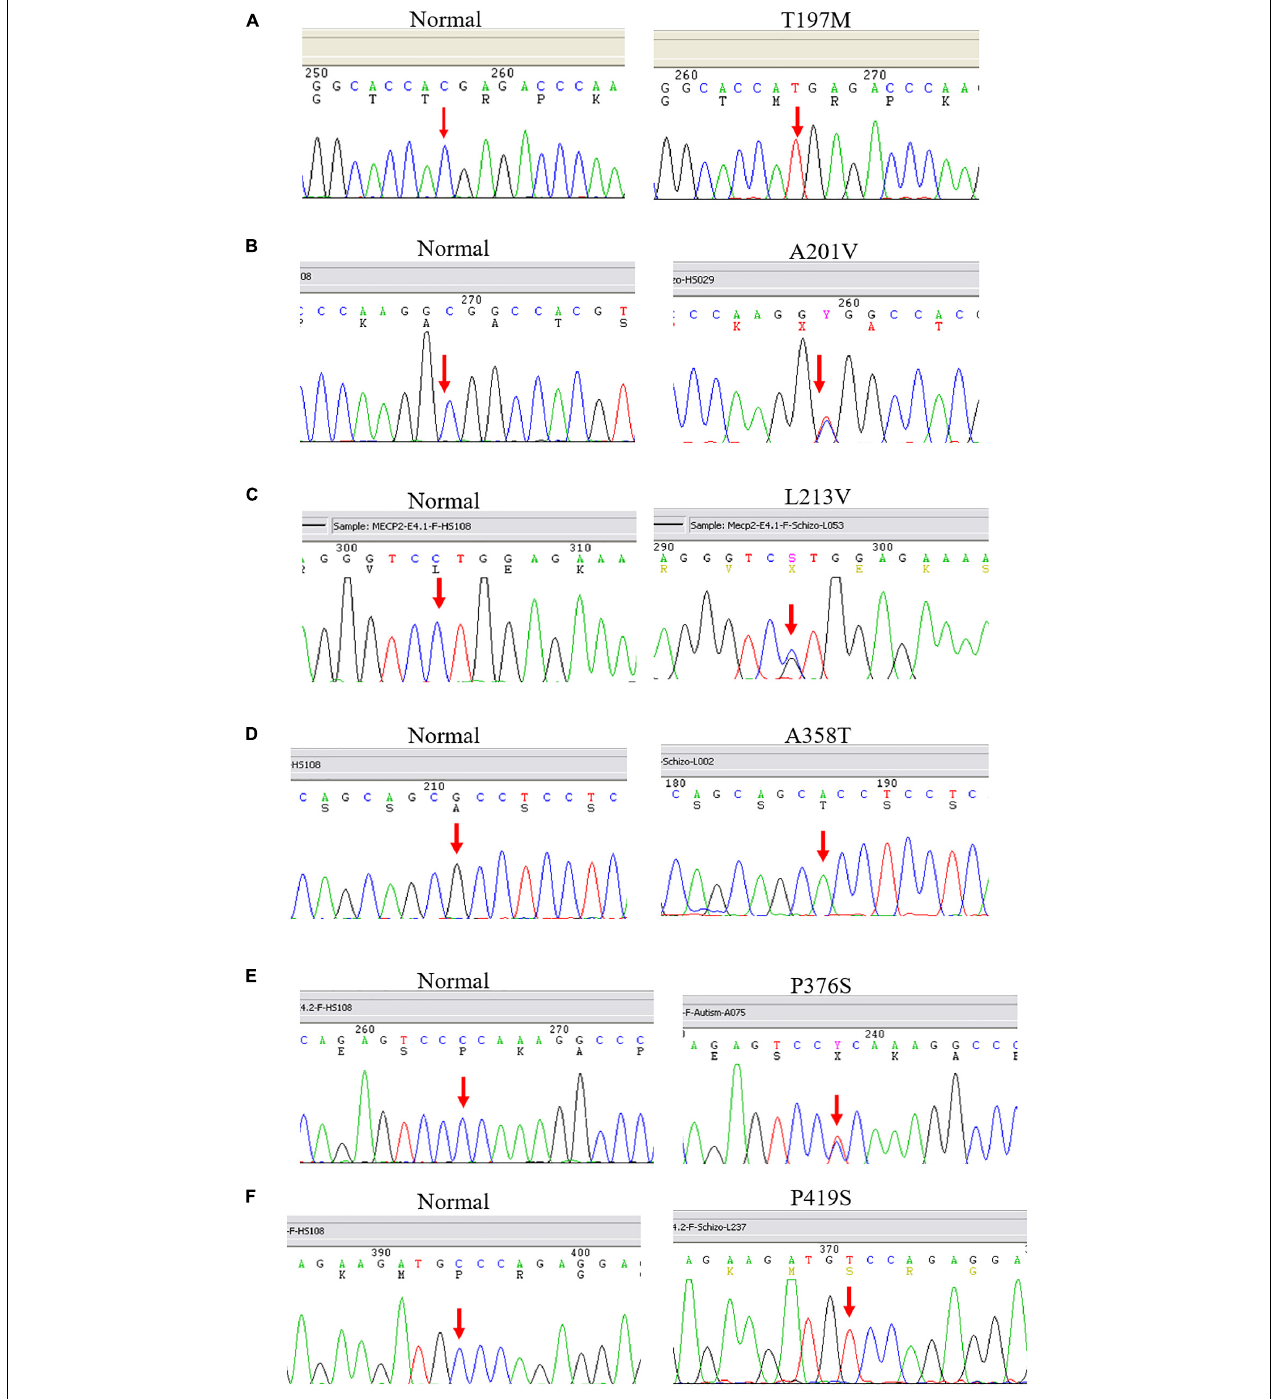
FIGURE 1 | Representative results of Sanger sequencing of six missense mutations identified in this study. The left panel is the reference sequence, the right panel is the mutant sequences. (A) A C-to-T substitution at the MECP2 cDNA sequence 590 changes amino acid 197 from threonine to methionine in a male patient. (B) A C-to-T change at the MECP2 cDNA sequence 602 leads to an amino acid alteration from alanine to valine at sequence 201 in a female patient. (C) A C-to-G substitution at the MECP2 cDNA sequence 637 results in amino acid sequence change from leucine to valine at position 213 in a female patient. (D) A G-to-A substitution at the MECP2 cDNA sequence 1072 changes amino acid sequence 358 from alanine to threonine in a female patient. (E) A C-to-T aleration at the MECP2 cDNA sequence 1126 changes the amino acid sequence 376 from proline to serine in a female patient. (F) A C-to-T change at the MECP2 cDNA sequence 1255 results in the alertation of amino acid sequence 419 from proline to serine in a male patient.